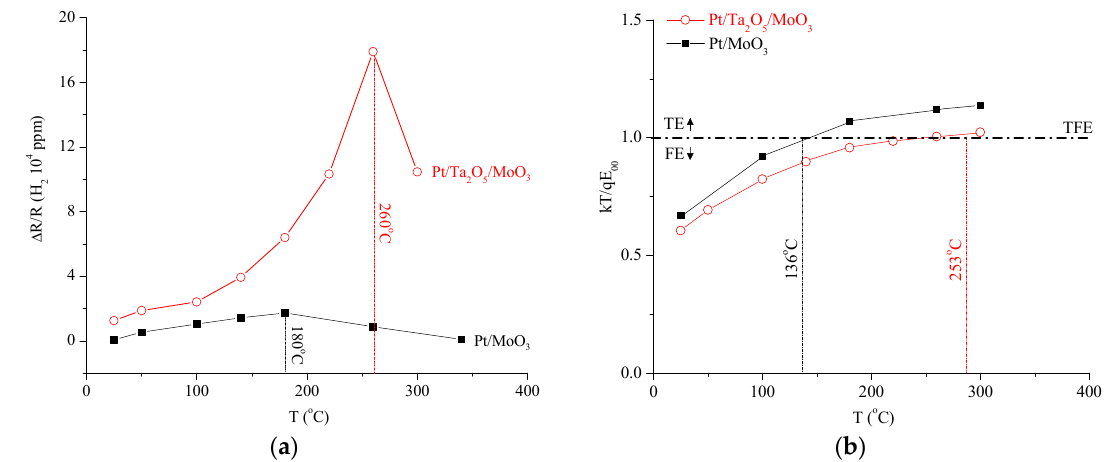
Figure 6. ( a ) Resistance change ( ∆ R/R) sensor response across temperature, as evaluated from I–V data of the Pt/MoO 3 Schottky contact and the Pt/Ta 2 O 5 /MoO 3 heterojunction. ( b ) Calculated kT/qE 00 vs. T. kT/qE 00 = 1 indicates Thermionic Field Emission (TFE) is the dominant transport mechanism, which correlates strongly with the largest resistance change for both devices, therefore providing a theoretical explanation for the optimal sensing temperature.